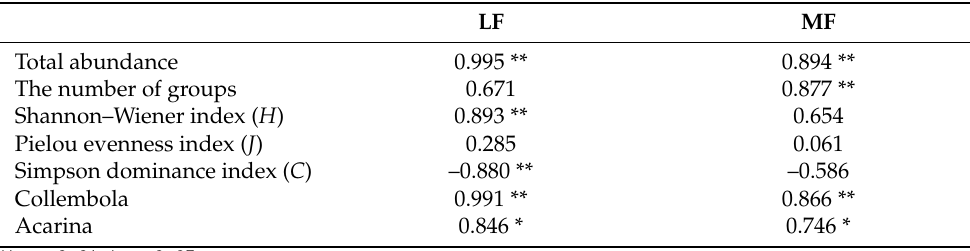
Table 6. Correlation coefficients between decomposition rate and abundance, group numbers, ecological indices of soil